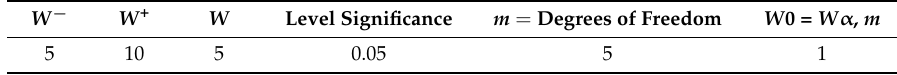
Table 14. Parameters for the statistical